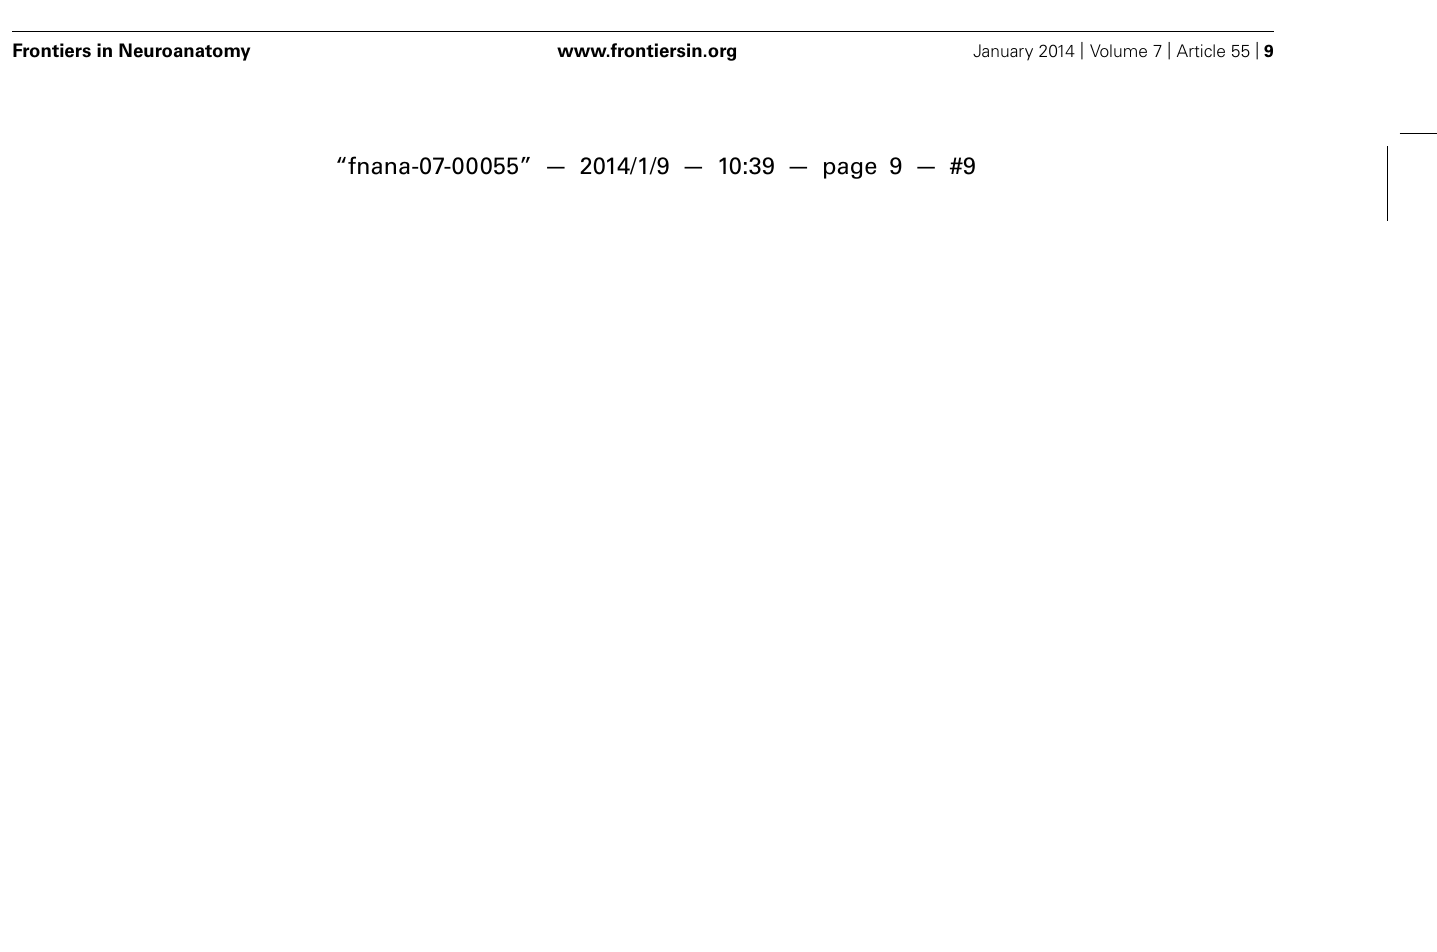
FIGURE 6 | Photomicrographs of labeled reticulotectal and medullary reticuloreticular neurons in MRF after paired injections into SC and MdRF. (A,B) The close relationship of DY labeled medullary reticuloreticular neurons (red arrows) and FG labeled reticulotectal neurons blue arrows) show spatial overlap between medullary reticuloreticular and reticulotectal neurons